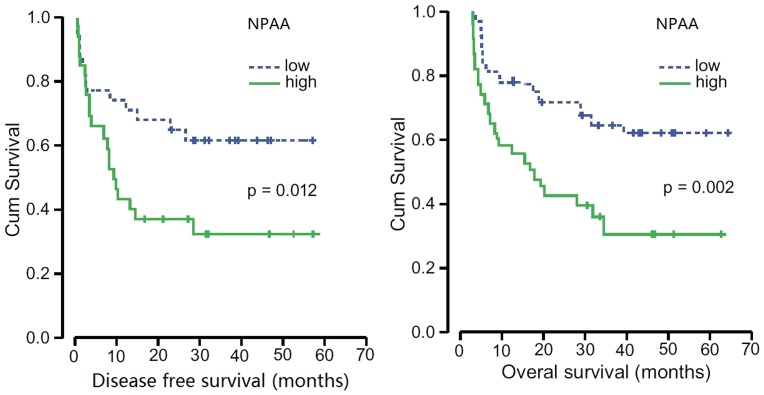
Kaplan-Meier curves of survival differences among NSCLC patients.Disease-free survival (A) and Overall survival (B) for low NPAA and high NPAA patients. P values were determined by the log-rank test.